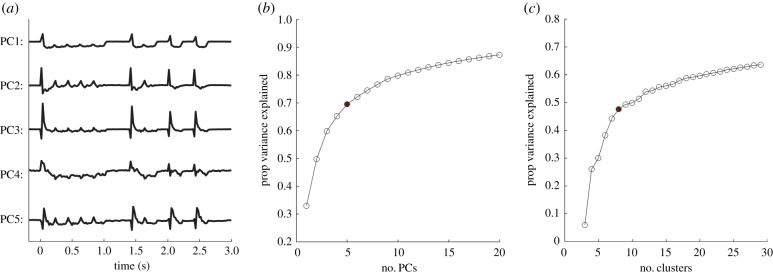
Principal component analysis for hierarchical clustering. (a) The first five principal components based on normalized firing rates. (b) The elbow method was applied to decide that five principal components would be used for clustering. (c) The elbow method applied again to decide that eight clusters adequately explained variance in the data. One of the eight clusters contained only one unit, and this cluster was discarded from further analysis, yielding the seven clusters referred to throughout. (Online version in colour.)